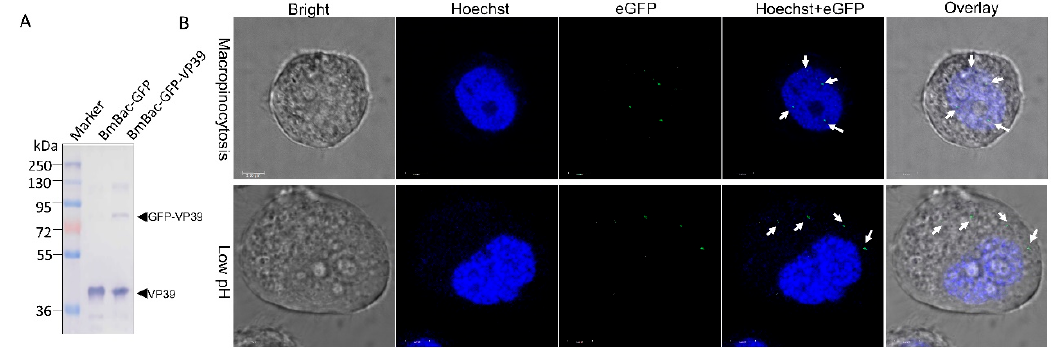
Figure 4. Viral particle tracing analysis on macropinocytosis and low-pH-induced DMF. (A) Western blot analysis of recombinant virus BmBac-GFP-VP39. BVs were collected by ultracentrifugation and were subjected to Western blotting. The arrows indicate VP39 (lower arrow) and GFP-VP39 (upper arrow). ( B ) Localization assay of eGFP-labeled nucleocapsids in the macropinocytosis and DMF treatment (2 h p.i.). The arrows show the nucleocapsids in the nucleus (upper panel) or in the cytoplasm (lower panel). Scale bar, 5 μ m.